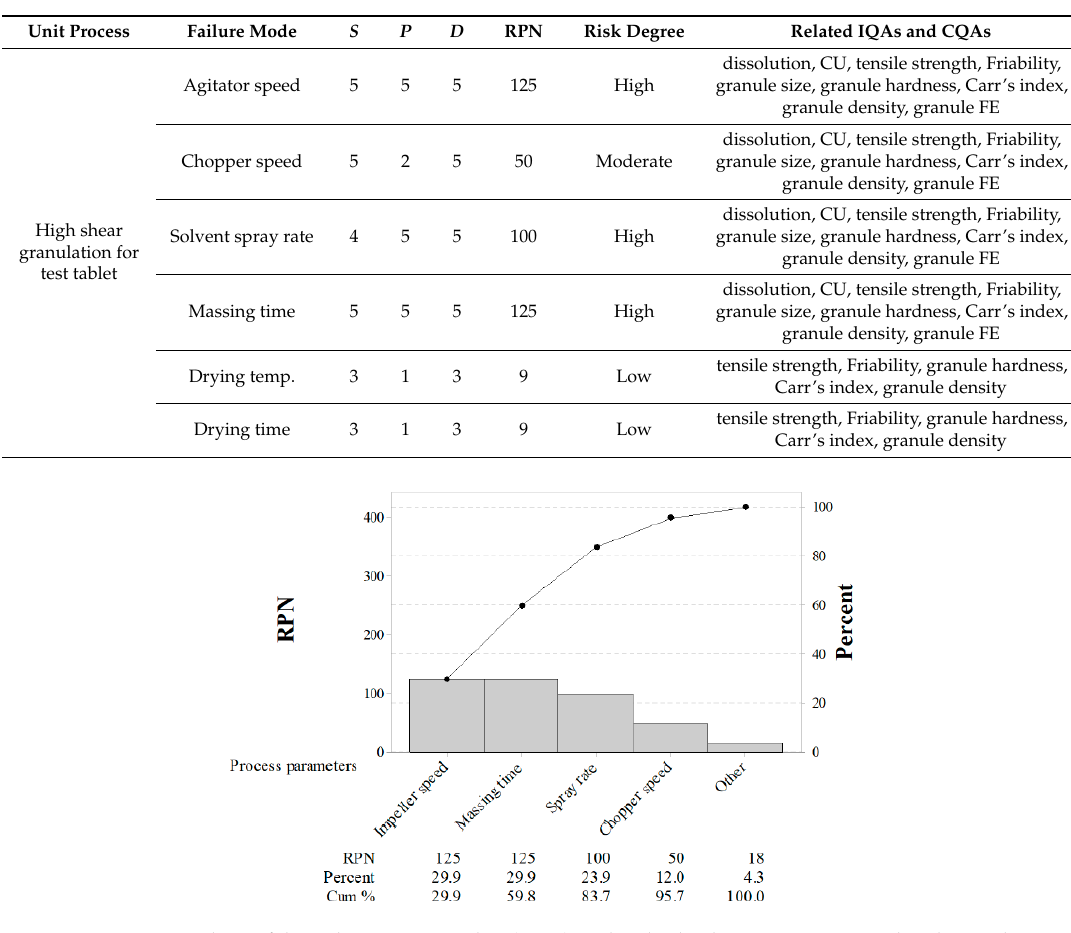
Table 2. Risk assessment based on prior knowledge and experience, and information about the control tablet from published literature or analyses. (RPN: risk priority number; IQAs: intermediate quality attributes; CQA: critical quality attribute; CU: content uniformity; FE: flow energy)